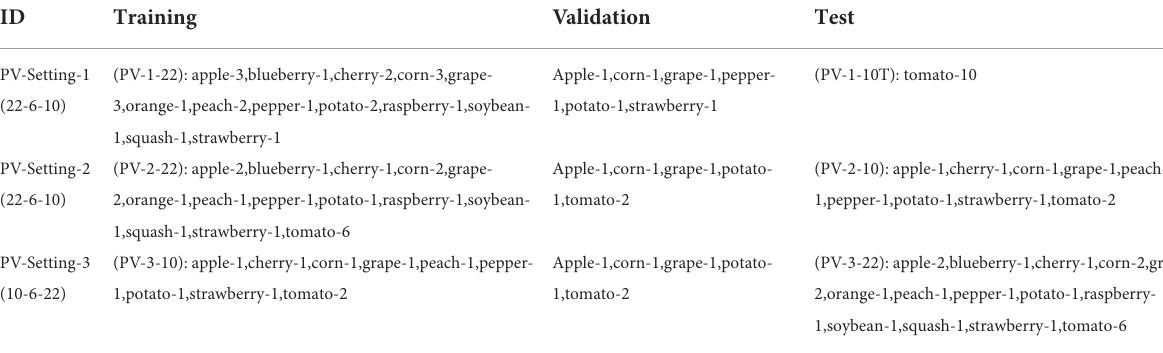
TABLE 3 Three data settings of PV used in our experiments.